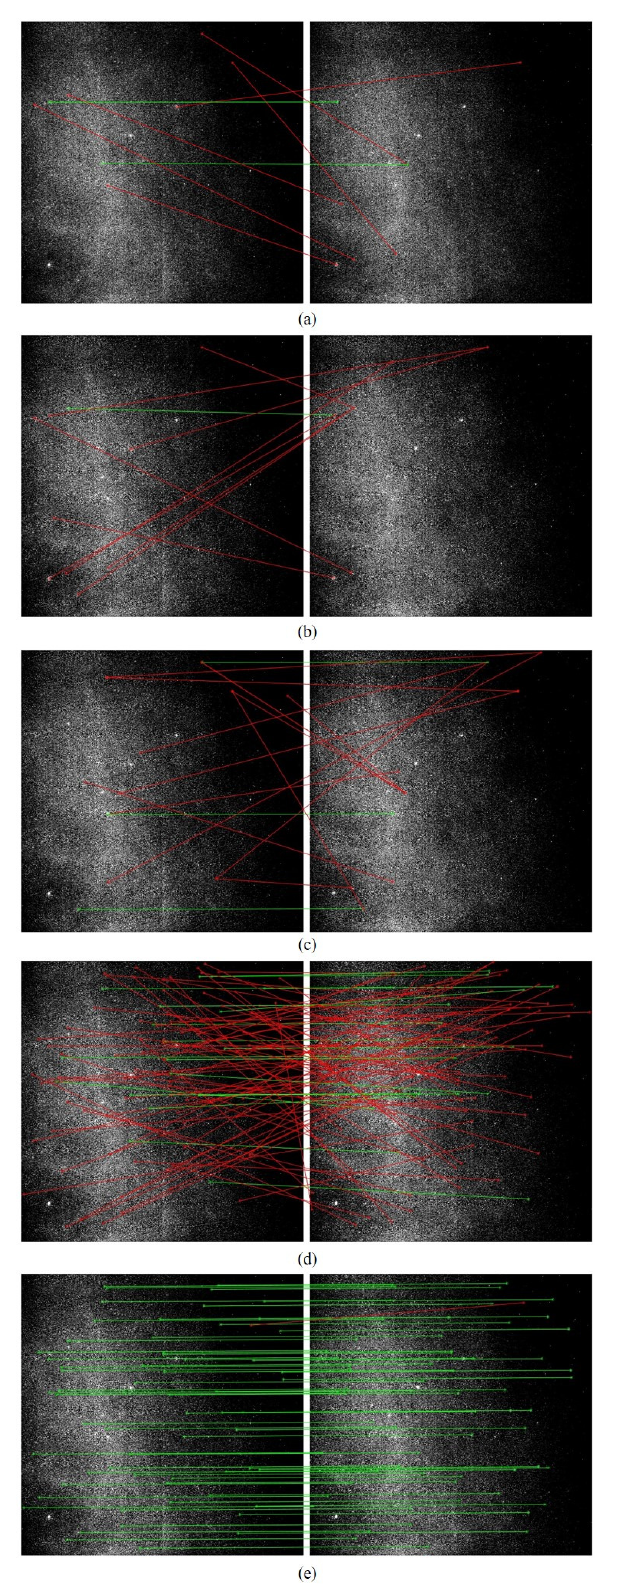
Figure 7. The results of matching for two images in Seq.2. ( a ) SURF. ( b ) Global threshold + improved SURF. ( c ) ORB. ( d ) Global threshold + Delaunay. ( e )